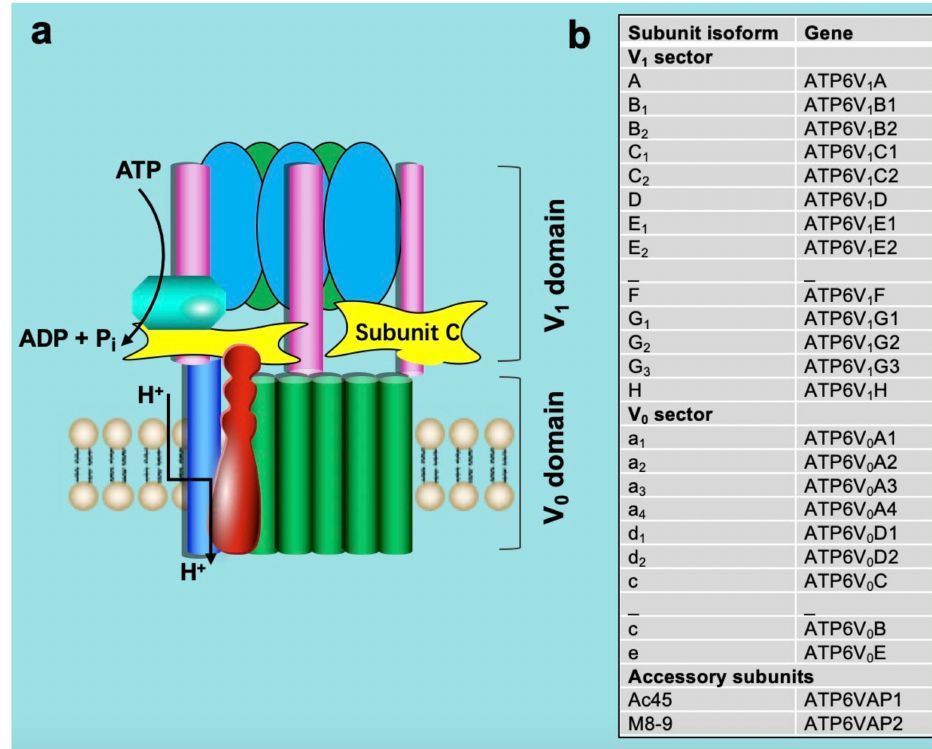
Figure 2. Structure ( a ) and subunit isoform ( b ) of vacuolar-type H + -ATPase. See text for detailed ex-